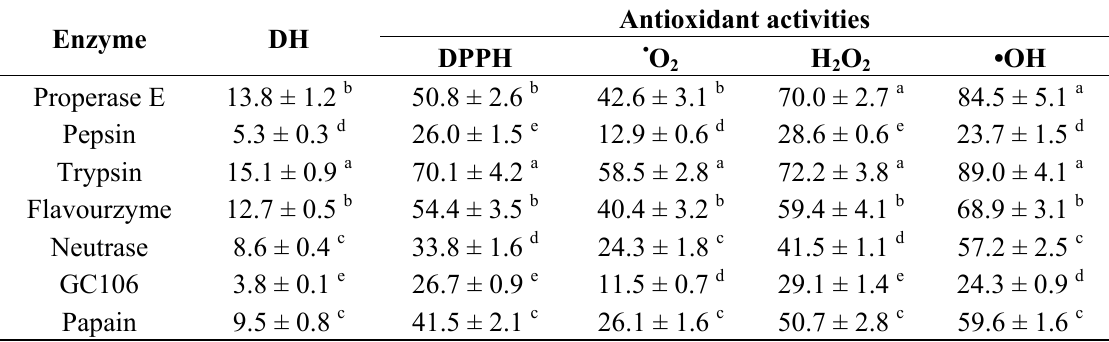
Table 1. The degree of hydrolysis (DH) and antioxidant activities of the hydrolysates from different protease